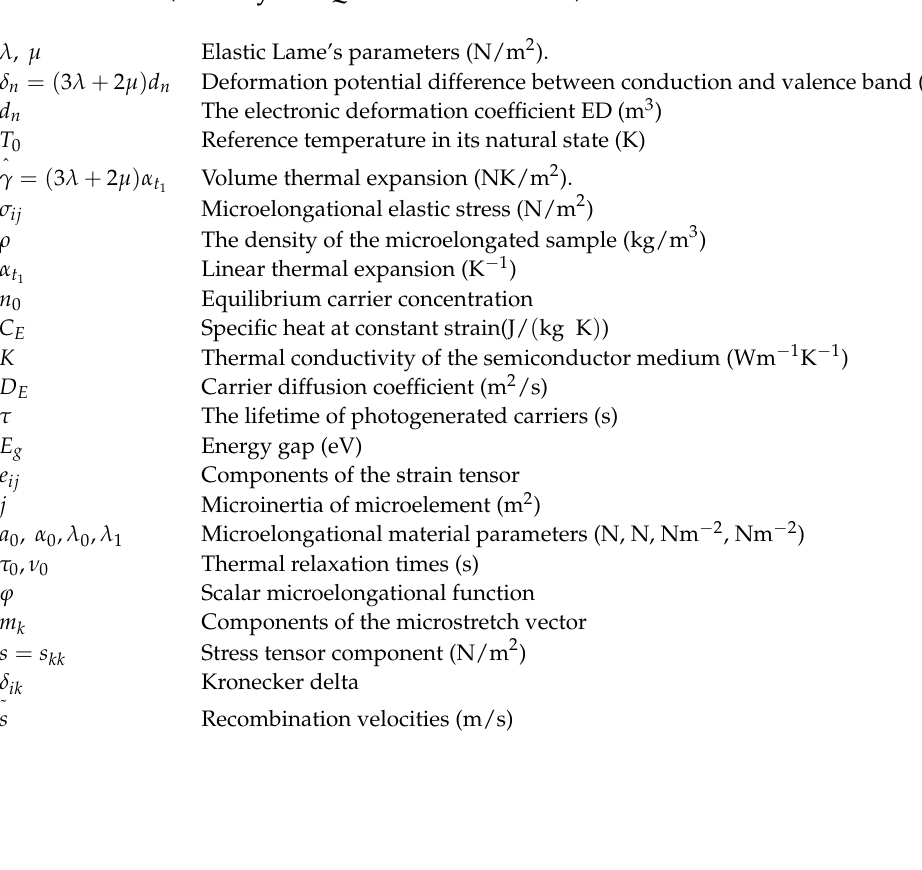
Nomenclature (The Physical Quantities with